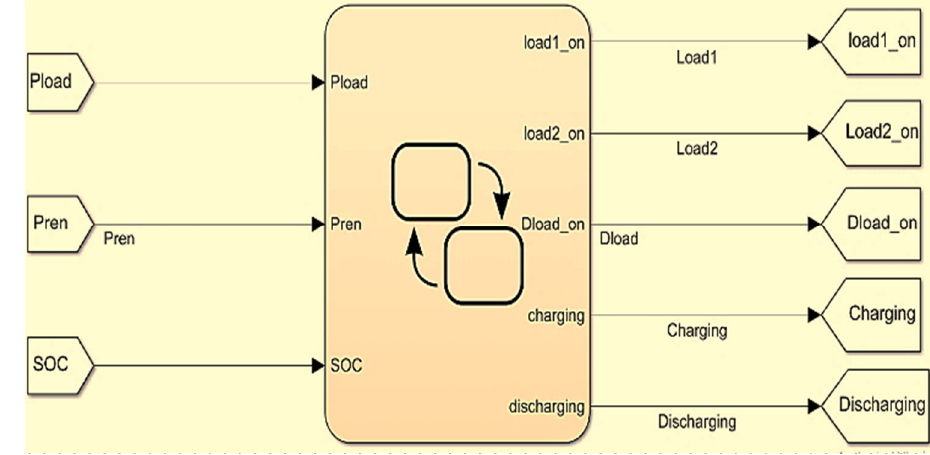
Fig. 4: State machine control block subsystem in Simulink